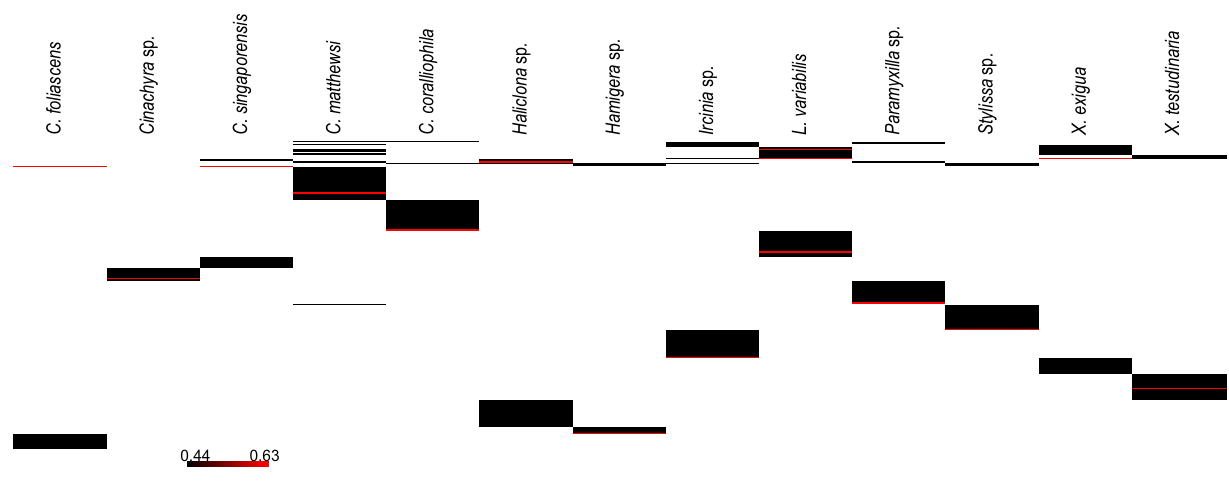
FIGURE 4 | OTU heatmaps generated with a distance of 0.03 for clone libraries from each sponge species. Whilst there are a small number of shared OTUs, the vast majority are